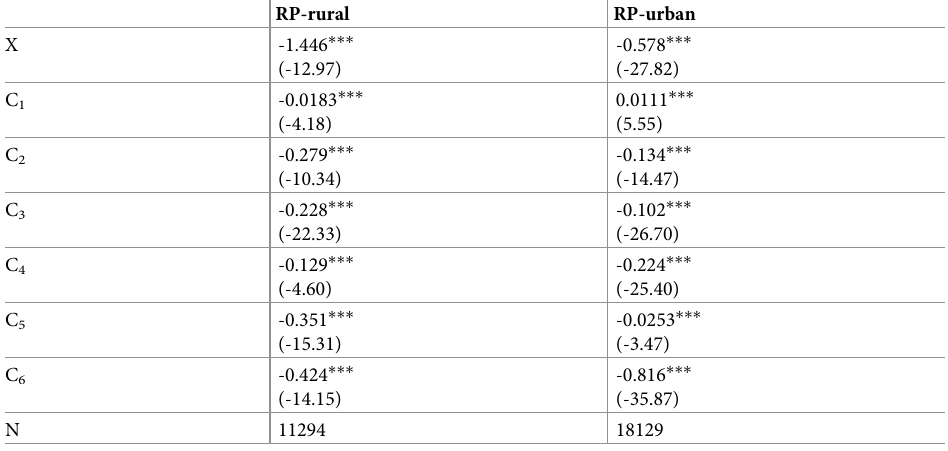
Table 11. Urban-rural heterogeneity test of the impact of digital finance on relative